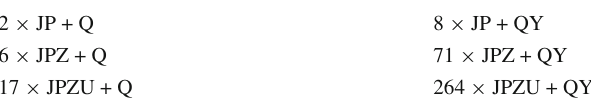
Table 2 Possible resonant superalgebras to construct